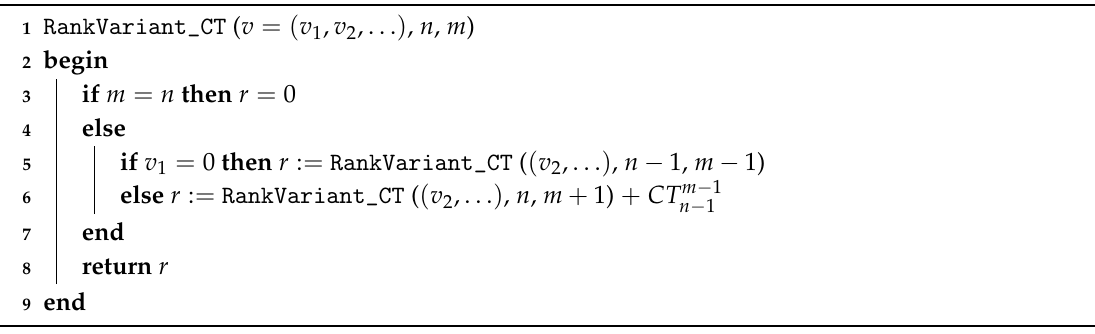
Algorithm 3: An algorithm for ranking the variants of the AND/OR tree for CT m